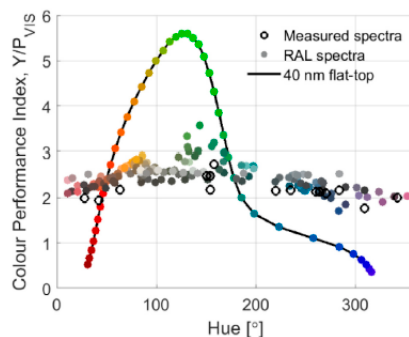
Figure 7. Colour performance index versus hue, and relative losses versus lightness, in the visible spectrum, as calculated by Røyset et al. [17]. Reproduced with permission from [17], copyright 2018, Elsevier.